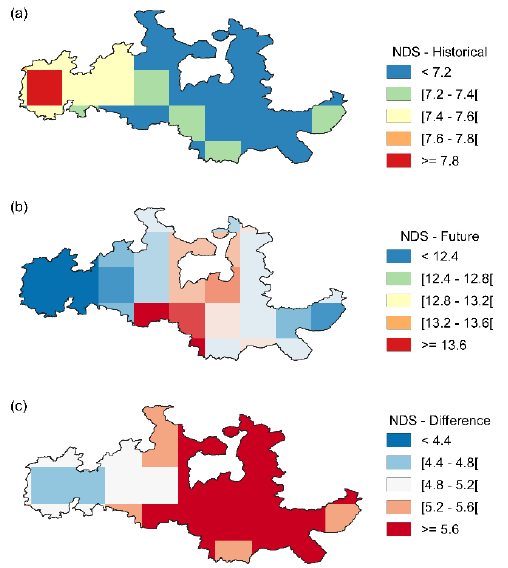
Figure 12. Ensemble-mean of the Number of Dry Spells (NDS) for the Douro Wine Region, bias- corrected by quantile mapping, for the ( a ) historical (1989–2005), ( b ) future (2051–2080) under the RCP8.5, and ( c ) future historical difference.